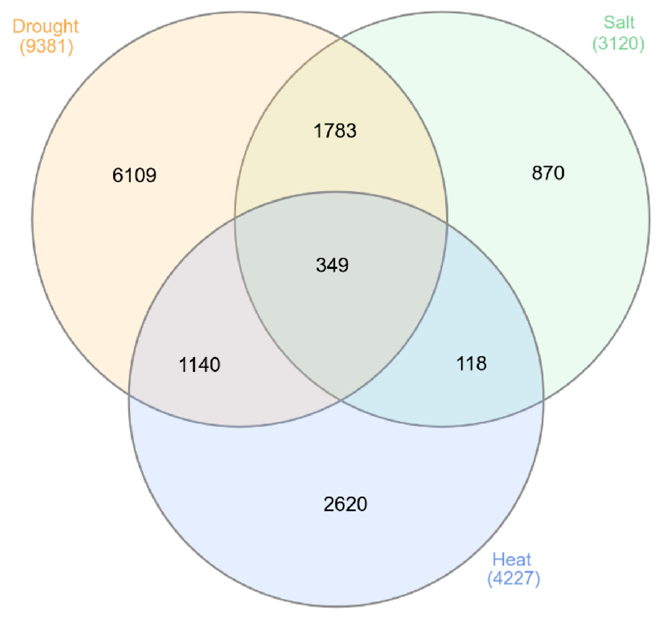
Figure 7. A Venn diagram representing the stress-responsive genes specific and common to drought, salinity and heat stress.